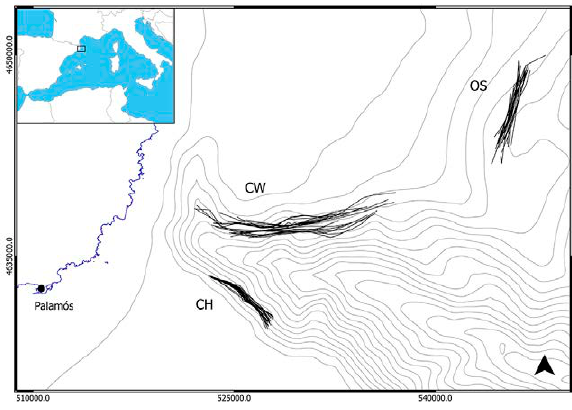
Fig. 2. – Map of the study area, i.e. the main fishing grounds for red shrimp exploited by the trawling fleet of Palamós (Catalonia, NE Spain). The fishing grounds are located on the margins of a sub- marine canyon (CH, canyon head; CW, canyon northern wall; OS, open slope). Tracks of the experimental tows are shown on the map.